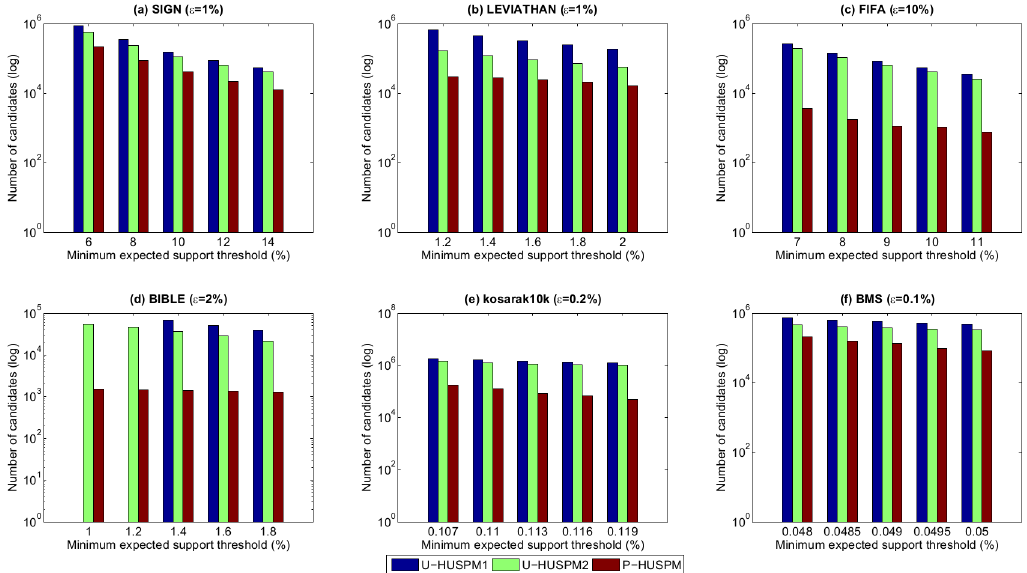
Fig 4. Number of candidates for a fixed ε when μ is